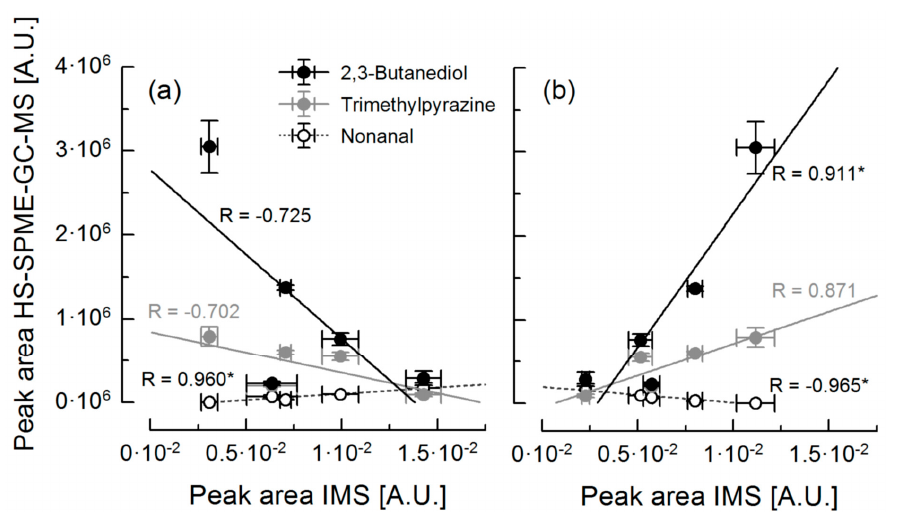
Figure 5. Correlation analysis of peak areas of 2,3-butanediol, trimethylpyrazine and nonanal determined by HS-SPME-GC-MS ( n = 2) and peak areas of peak 1 ( a ) and peak 7 ( b ) of IM spectra ( n = 3) of bulk cocoa samples. * marked correlation coefficients are significant ( p < 0.05). [A.U.]: arbitrary